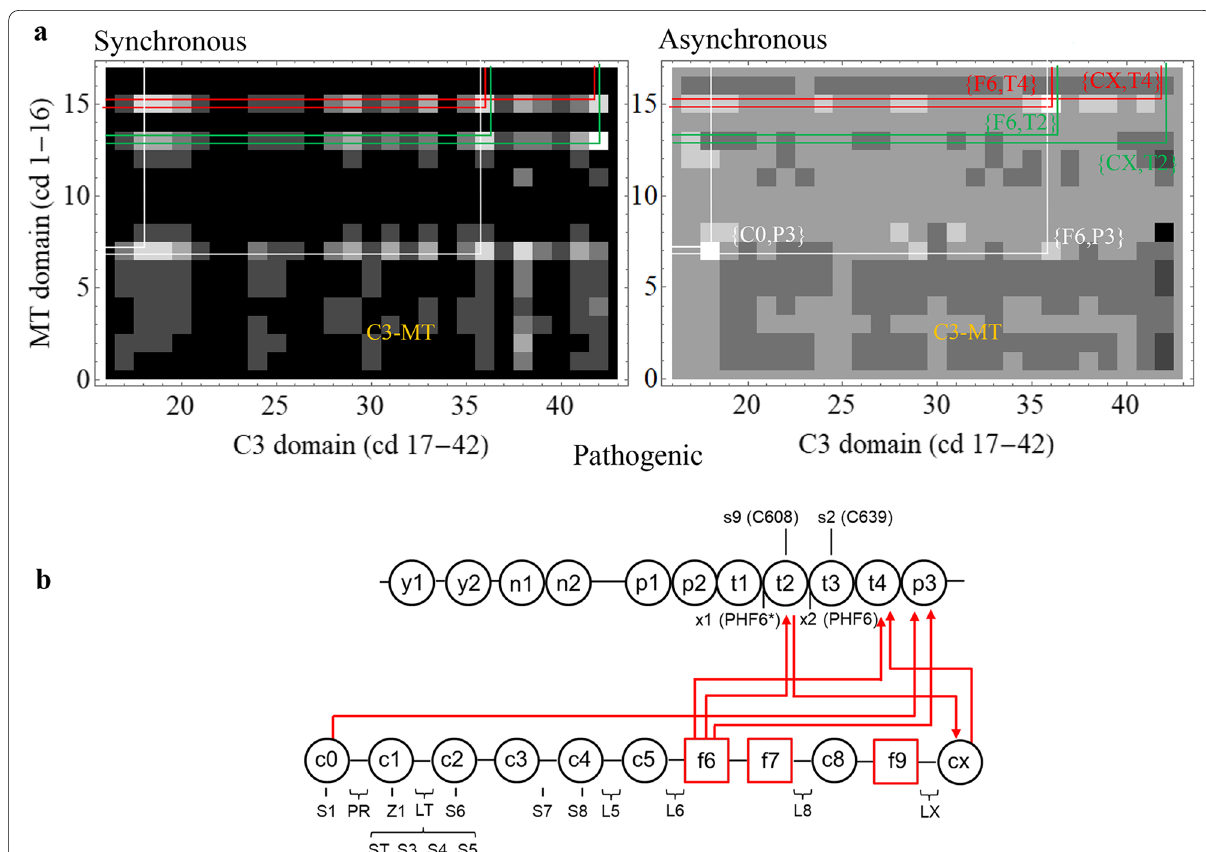
Fig. 7. MAPT/MYBPC2 complex cross-correlation maps and their implied inter-protein domain linkages for pathogenic outcomes. a C3-MT region for synchronous and asynchronous maps and the portion of the correlation squares falling within them for pathogenic outcomes taken from Supplementary Figure S5. b Red lines show most significant directed co-domain interactions between MAPT and MYBPC3 for pathogenic outcomes. Nomenclature otherwise identical to Figs. 4 and